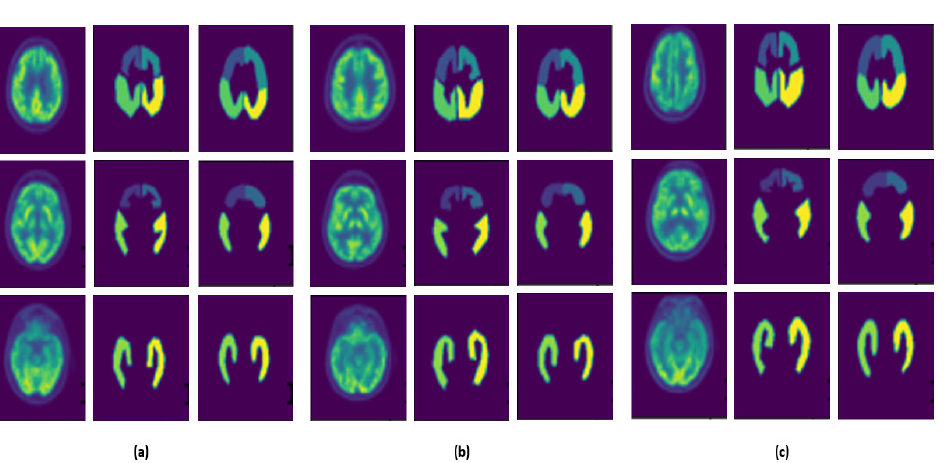
Figure 6. Comparison between 18F-FDG PET slices for three example subjects (first column), ground truth (second column), and automatic segmentation via U-Net3D (third column) for ( a ) control patient, ( b ) MCI patient, and ( c ) AD patient.